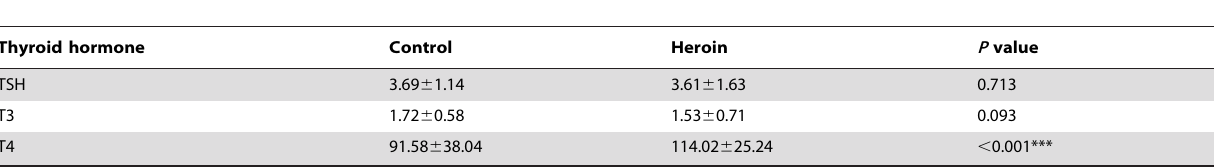
Table 4. Comparison of TSH, T3 and T4 concentrations (nmol/L) in the serum of healthy controls versus heroin addicts.